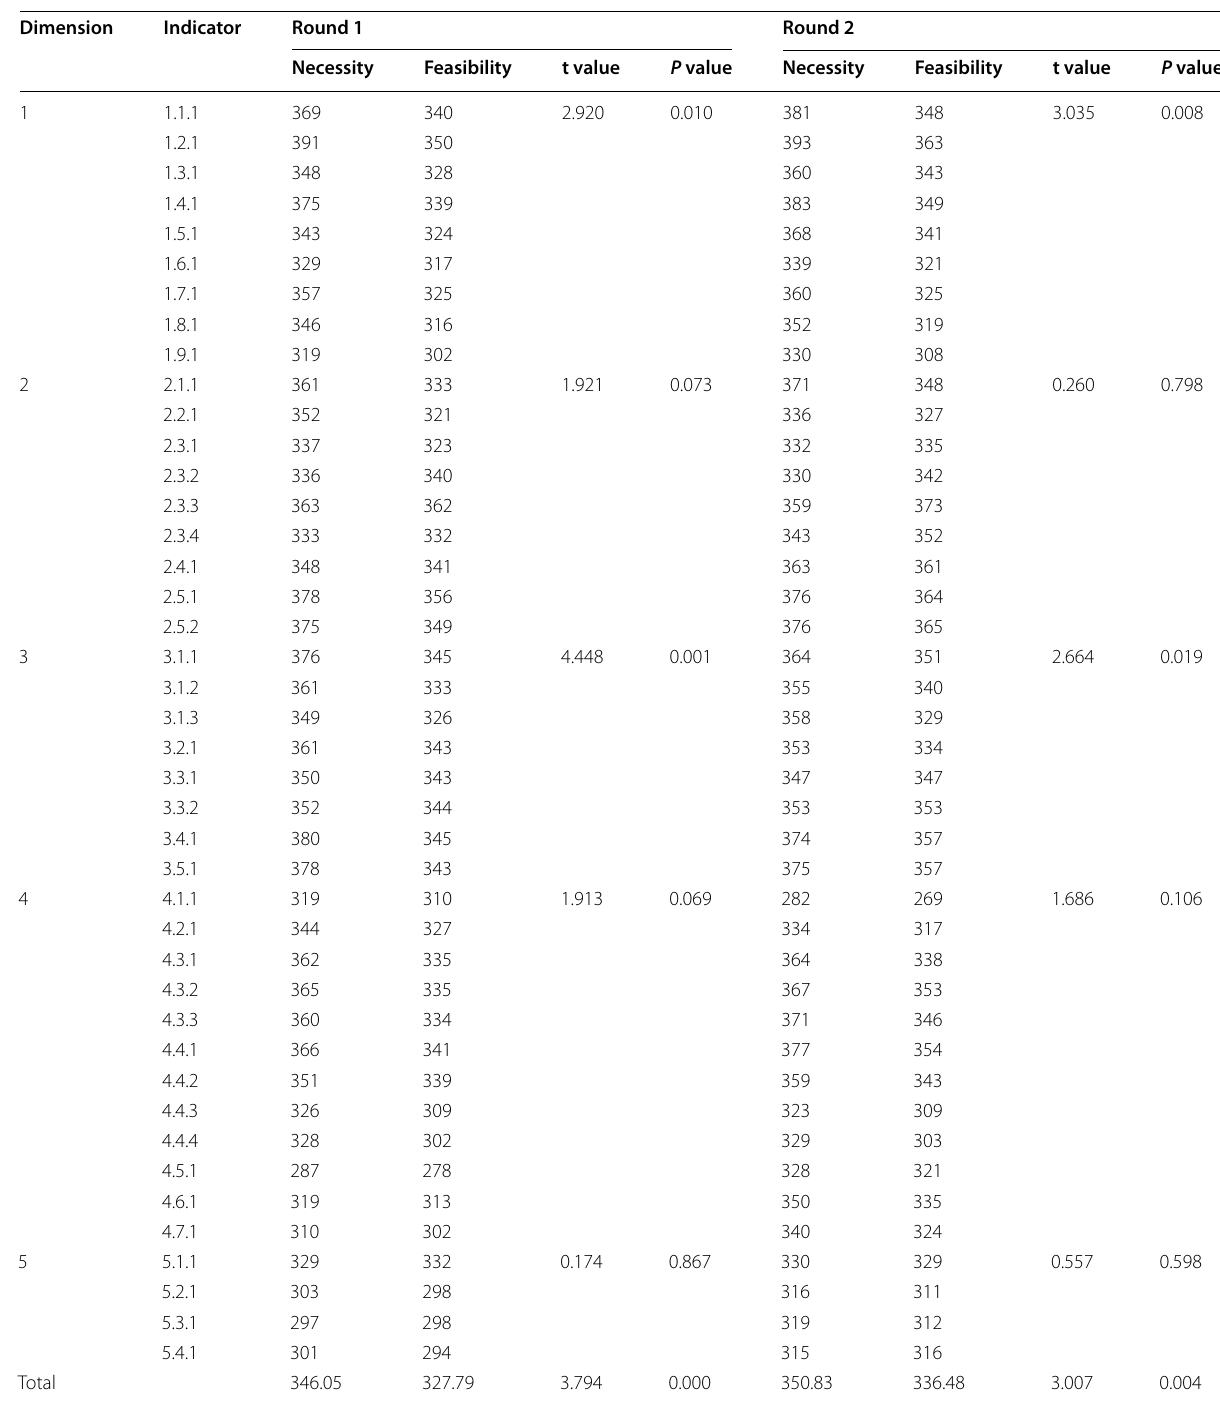
Table 2 The scores of expert judgments for the indicators in necessity and feasibility Dimension